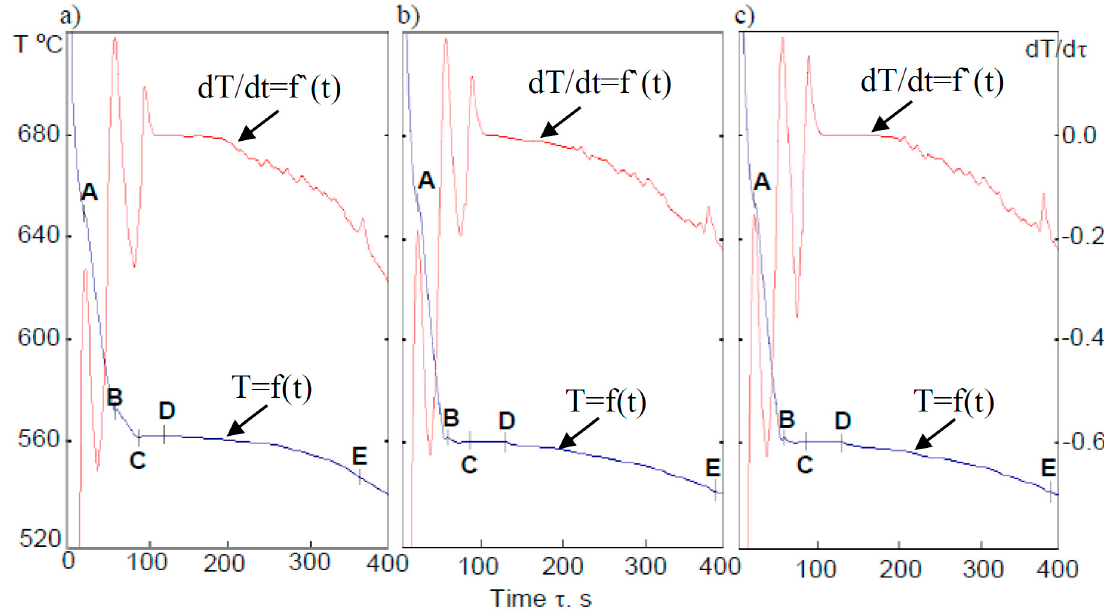
Figure 2. Graph of ATD thermal analysis of alloy AlSi10Mg0.5Mn0.5: ( a ) without addition of powder with characteristic points, ( b ) with addition of powder-1, and ( c ) with addition of powder-2 with characteristic points.